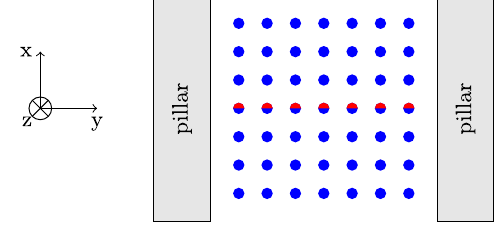
FIG. 2. Integration paths (blue dots) and beam paths (red dots) in the CST simulation. For each beam path the simulation is performed and the resulting wakefields are recorded in every integration